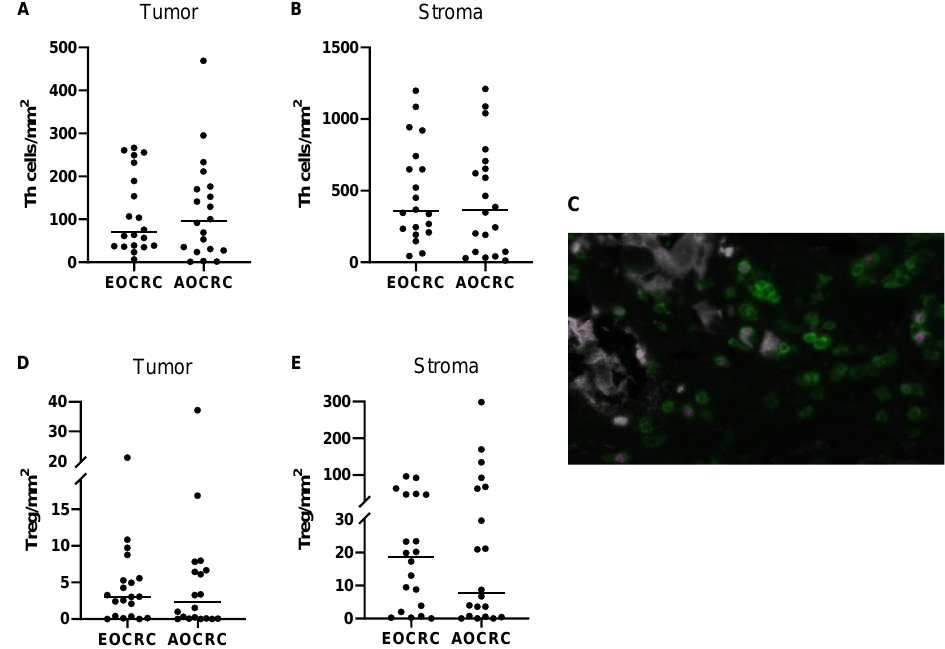
Figure 3. CD4 + T cells in the tumor microenvironment. The density of Th cells (CD3 + CD8 − FoxP3 − cells) and Treg (CD3 + CD8 − FoxP3 + cells) in tumors from early-onset (EOCRC) and average-onset colorectal cancer (AOCRC) patients was determined by immunofluorescence in tumor tissue ( A , D ) and tumor stroma ( B , E ). ( C ) Representative immunofluorescence image from an AOCRC patient with tumor cells (panCK, grey), CD3 + T cells (green), and FoxP3 + Treg (magenta). Magnification 300×. Symbols show individual values, and lines indicate the median.